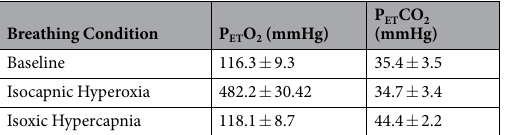
Table 1. Average P ET O 2 and P ET CO 2 values and SD for each breathing condition. Data shown includes every measurement taken at the time of imaging for each